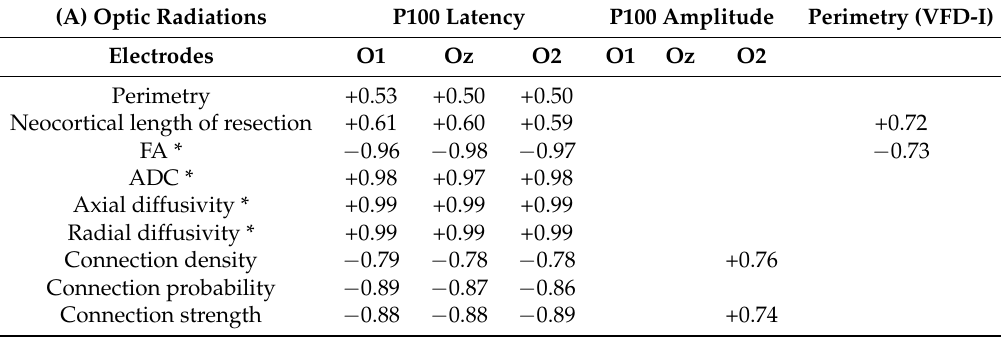
Table 7. Correlations with statistical significance between the anatomical variables, quadrant visual evoked potentials and the